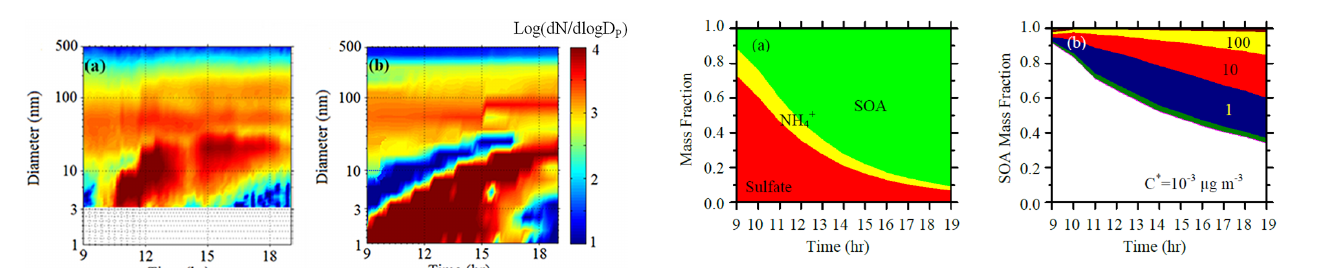
Figure 3. Comparison of (a) measured on 10 April 2007 and (b) predicted (with aging of bSOA precursors and σ = 0.025Nm − 1 ) dry size distribution as a function of local time at Hyytiälä for a typical nucleation event day.